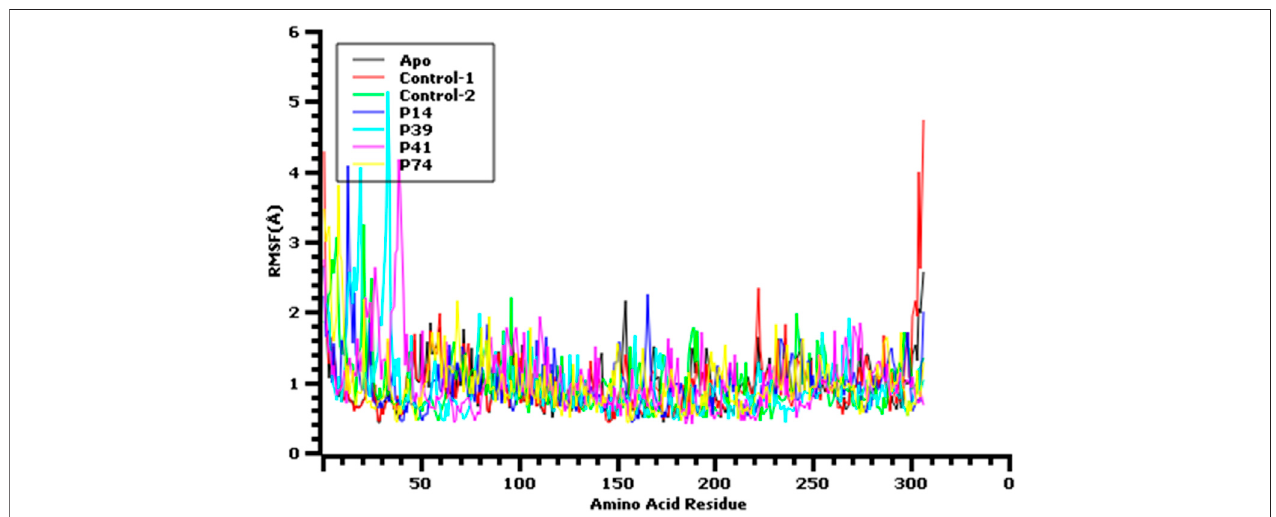
FIGURE 7 | Principal component analysis (PCA) showing the Biplot of top 15 high-binding af fi nity peptides clustered based on four peptide properties.